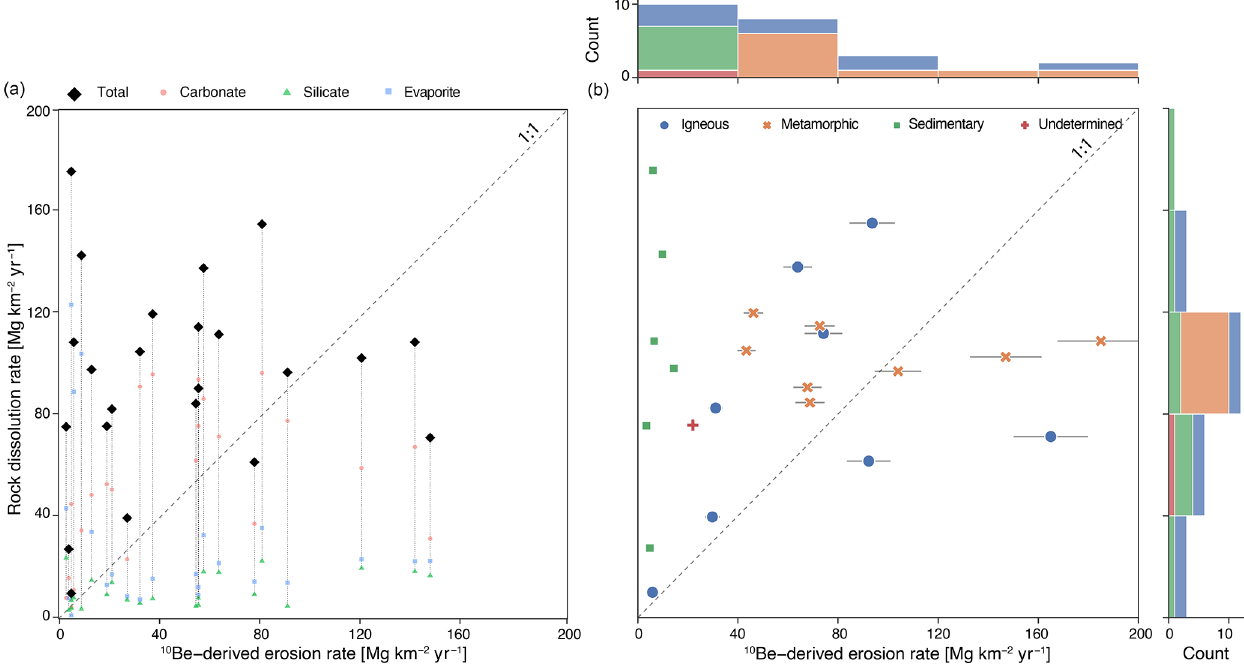
Figure 7. Scatterplot of rock dissolution rates vs. 10 Be-derived erosion rates. (a) Data shown for calculations of carbonate, silicate, and evaporite dissolution rates. (b) Data shown for dominant lithologies underlying each sampled basin. Horizontal lines extending from the points demonstrate the uncertainty associated with the calculation of 10 Be-derived erosion rates. Histograms on axes show the distribution of data. The dashed line is